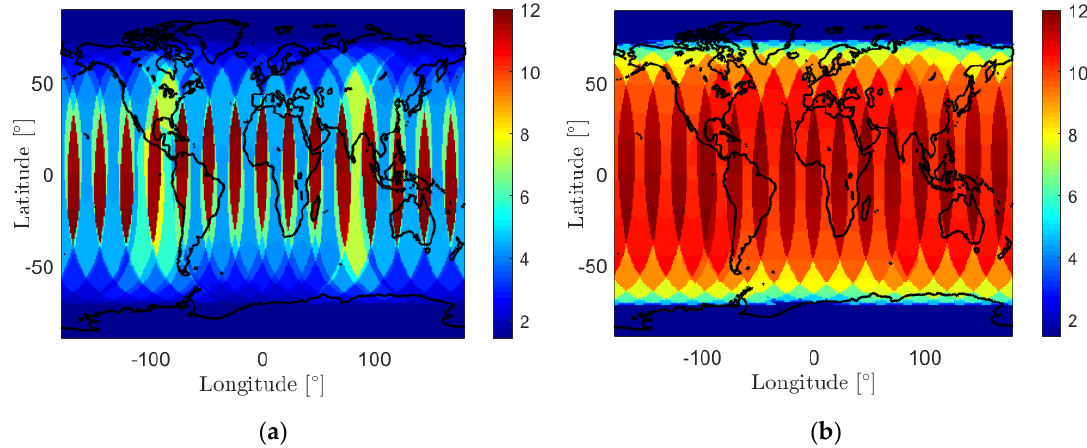
Figure 3. ( a ) The mean and ( b ) the maximum time gaps between subsequent satellite visible periods for GRACE FO-1 on 14 August 2018. The almost equal colors around the North and the South Poles are caused by the spherical shape of the Earth and the form of the map. Table 1. Minumum number of the land-based GMSs required to guarantee an observation gap not exceeding ∆ T gap . The data of GRACE FO-1 on 14 August 2018, were used for the calculation. Latitude ( B ) Range ∆ T gap = 1 h ∆ T gap = 2 h ∆ T gap = 3